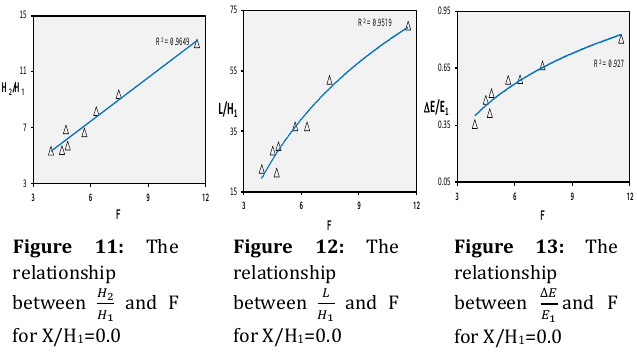
Figure 1: [a] the isometric of the laboratory model [b] the used incomplete circular piles [c] the different arrangements of incomplete circular piles for the first phase stage of the work. [d] the different